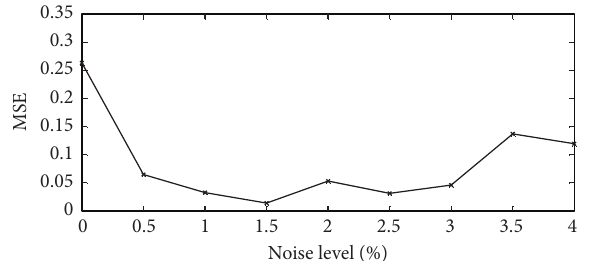
Figure 6: Experimental mean sizing error for different levels of injected